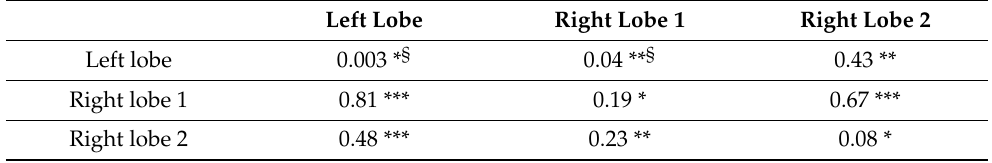
Table 1. p -values derived from the comparison of different liver segment linear regression analyses. Significant p -values ( p < 0.05) are denoted by § . * denotes comparison between group A and B, ** within group A, and *** within group